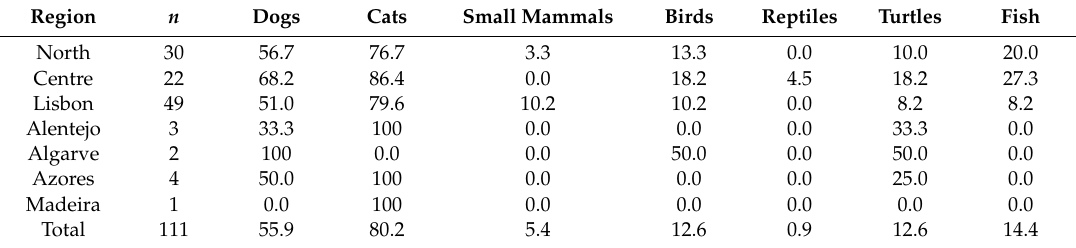
Table1. Portuguese pet owners (%) reporting to have different animal types in their household, by region. Region n Cats Small